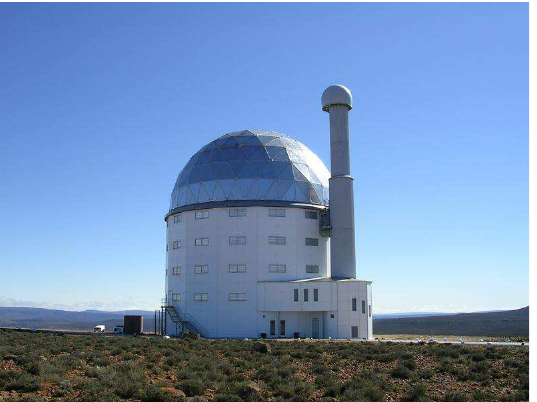
Figure 5: The Southern African Large Telescope (SALT).